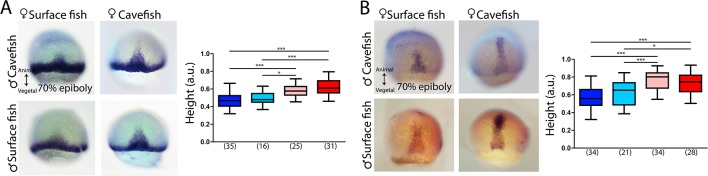
Maternal effect during mid-gastrulation.Expression of ntl (A) and lefty1 (B) at 70% of epiboly. (A, B) HybSF (top left), cavefish (top right), surface fish (bottom left) and HybCF (bottom right). Quantification of height in ntl- (A, right) and lefty1-labeled (B, right) embryos at 70% epiboly. Color code: surface fish, blue; HybSF, light blue; HybCF, pink; and cavefish, red.